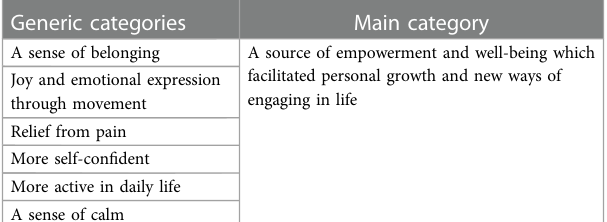
TABLE 4 The girls ’ experiences of the just in TIME dance and yoga intervention, in six generic categories and one main